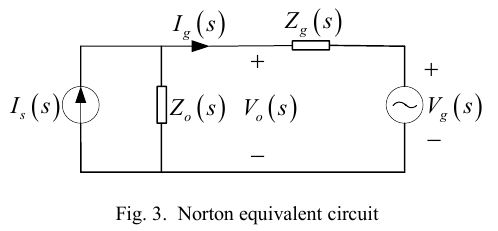
Fig. 4. Bode plot of the compensated and uncompensated system